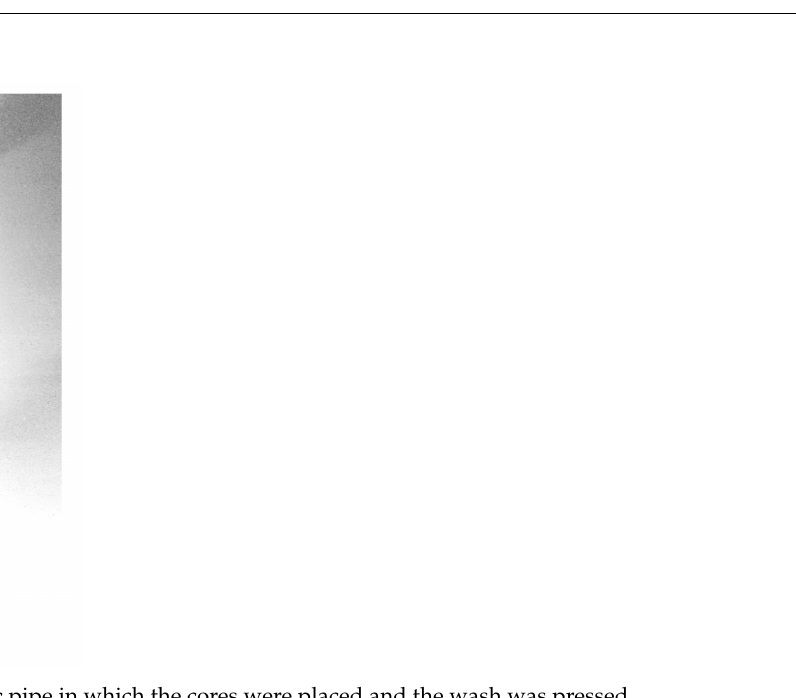
Figure 7. Plastic pipe in which the cores were placed and the wash was pressed. The developed methodology allowed determining the efficiency of washing mud removal by the pumped washing liquid. The adhesion to the contact between the hardened cement slurry and the rock formation was tested before and after washing. The core samples with the formed mud cake, after washing with the washing liquid, were placed in a tripod (Figure 8) and filled with cement slurry (Figure 9). After a binding time of 48 h, the adhesion was tested between the cement stone and the sandstone core. For this purpose, the samples were placed in a testing machine (Figure 10) and the breaking force of adhesion at the contact of the surfaces was measured.